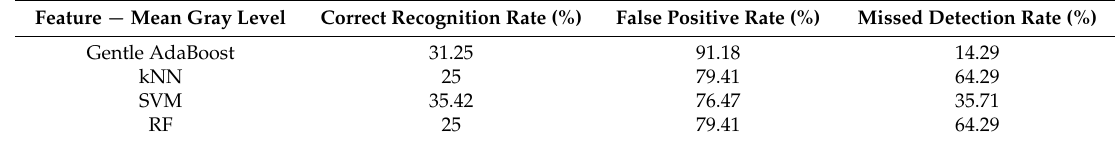
Table 5. Experimental results of constructing different recognition models based on mean gray level.